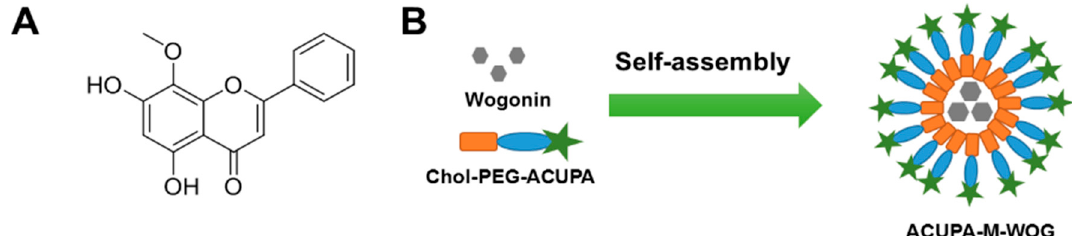
Figure 1. ( A ) The chemical structure of wogonin; ( B ) Schematic representation of self-assembled 2-(3-(( S )-5-amino-1-carboxypentyl)ureido)pentanedioic acid (ACUPA) modified polyethylene glycol (PEG)-Cholesterol micelles containing wogonin (WOG) (ACUPA-M-WOG).